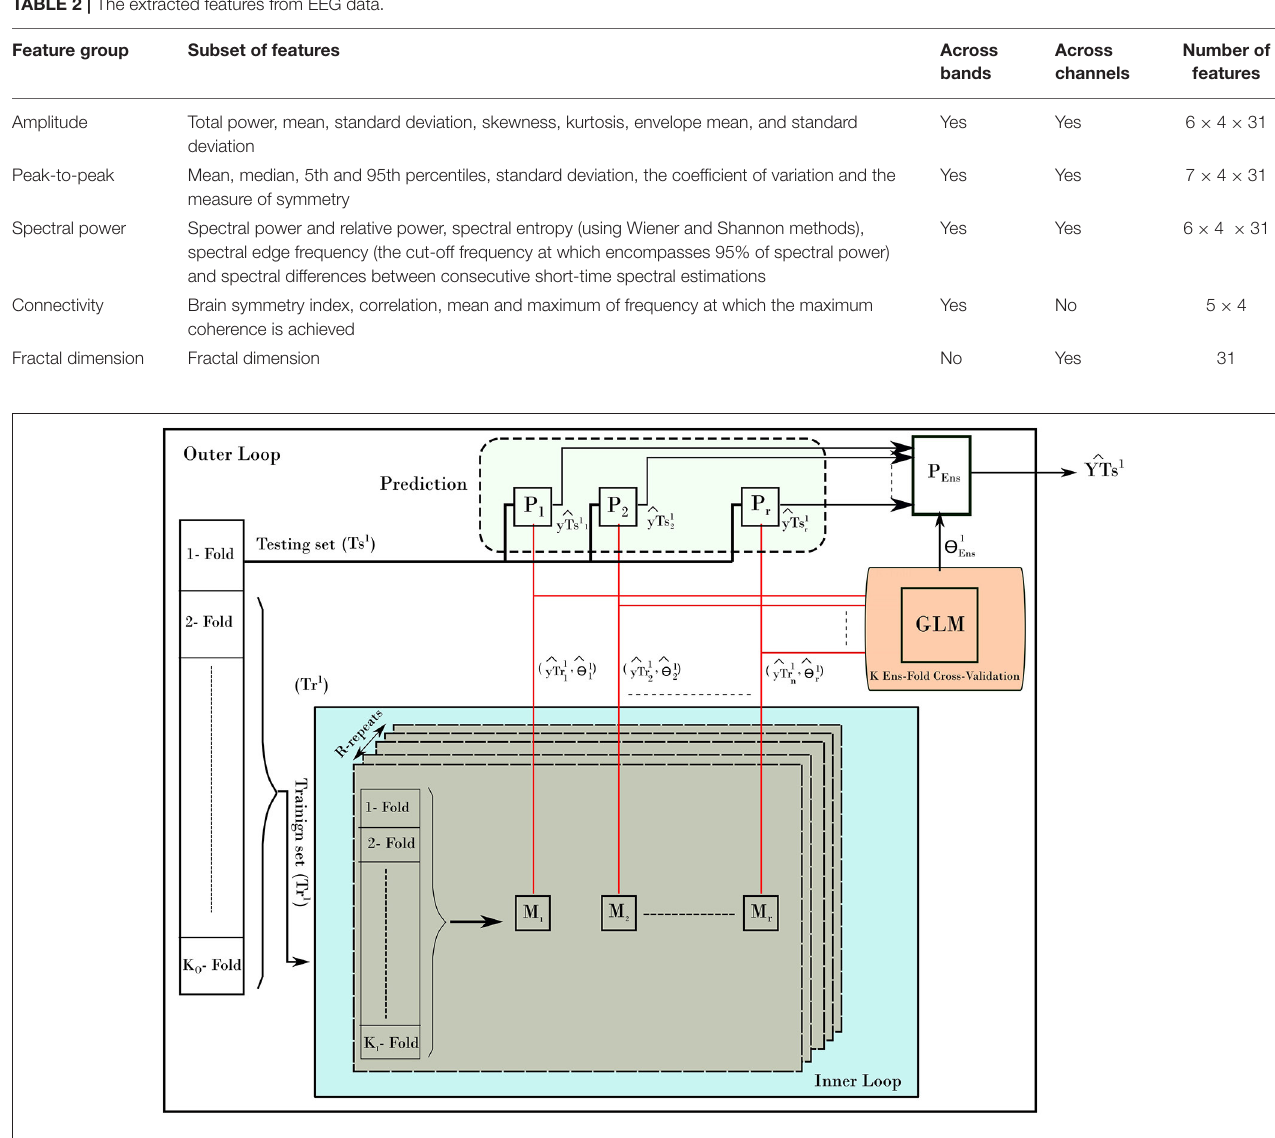
FIGURE 2 | The nested-cross-validation procedure for predicting age. The example here demonstrates the first fold of the outer loop. The procedure consists of an inner loop (blue color) and outer loop. The inner loop is used to find the best models to predict the age. The outer loop uses those models to predict the age on the testing set. The process is repeated for all folds of the outer loop, which results in building a prediction of age from all samples.